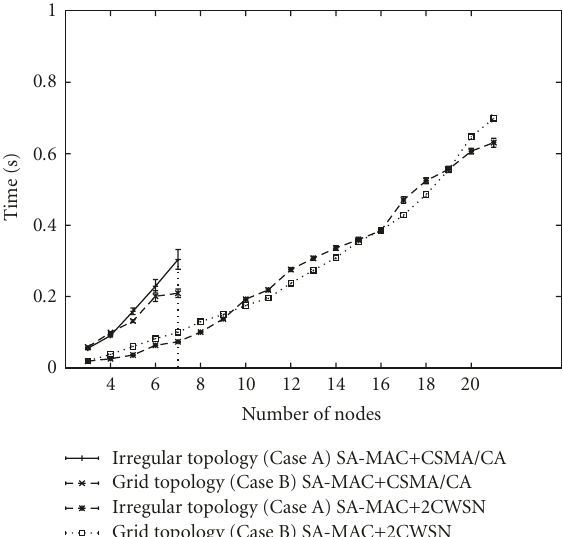
Figure 2: Examples of the spatial node distribution for Case A (black dots) and Case B (white dots). Figure 3: Network setup times for Case A and Case